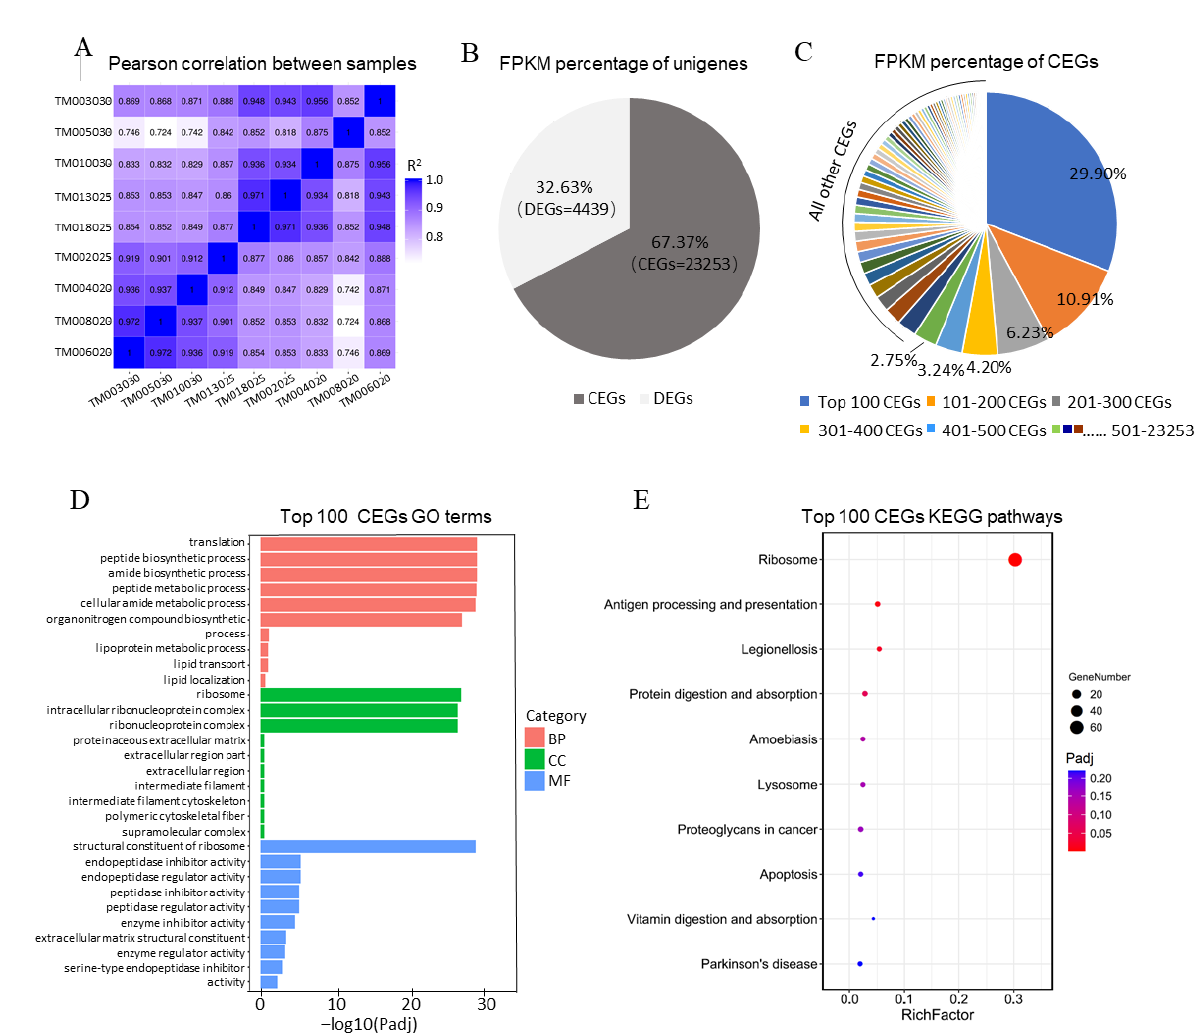
Figure 2. The expression profiling and gene annotation of commonly expressed genes (CEGs) on the 20th, 25th, and 30th days of pregnancy in Dazu Black goats. ( A ). Pearson correlation analysis of all trophoblast samples in response to the three-time points of pregnancy. ( B ). Pie chart showing the distribution of total FPKM in commonly expressed genes (CEGs) and differently expressed genes (DEGs). ( C ). Pie chart showing the distribution of the total FPKM in every 100 CEGs. ( D ). Gene ontology (GO) functional classification of common highly expressed genes (ChEGs) (The top 100 CEGs). BP; biological process, MF; molecular function, CC; cellular component. ( E ). Kyoto encyclopedia of genes and genomes (KEGG) pathway enrich of ChEGs (The top 100 CEGs).